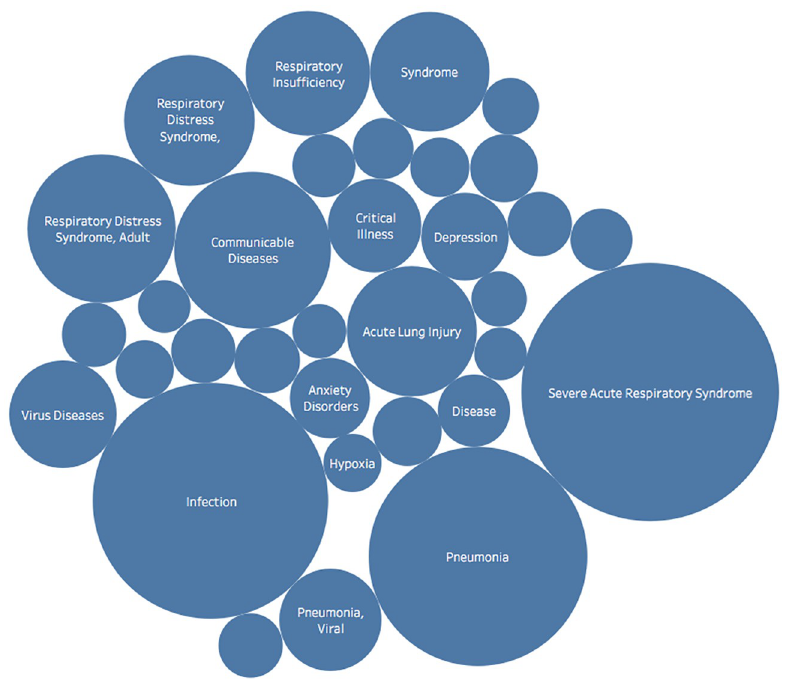
Fig 7. MeSH information details the most prevalent MeSH terms across COVID-19 related clinical trials. Some notable and expected prominent terms are Infections, Severe Acute Respiratory Syndrome, and Pneumonia.